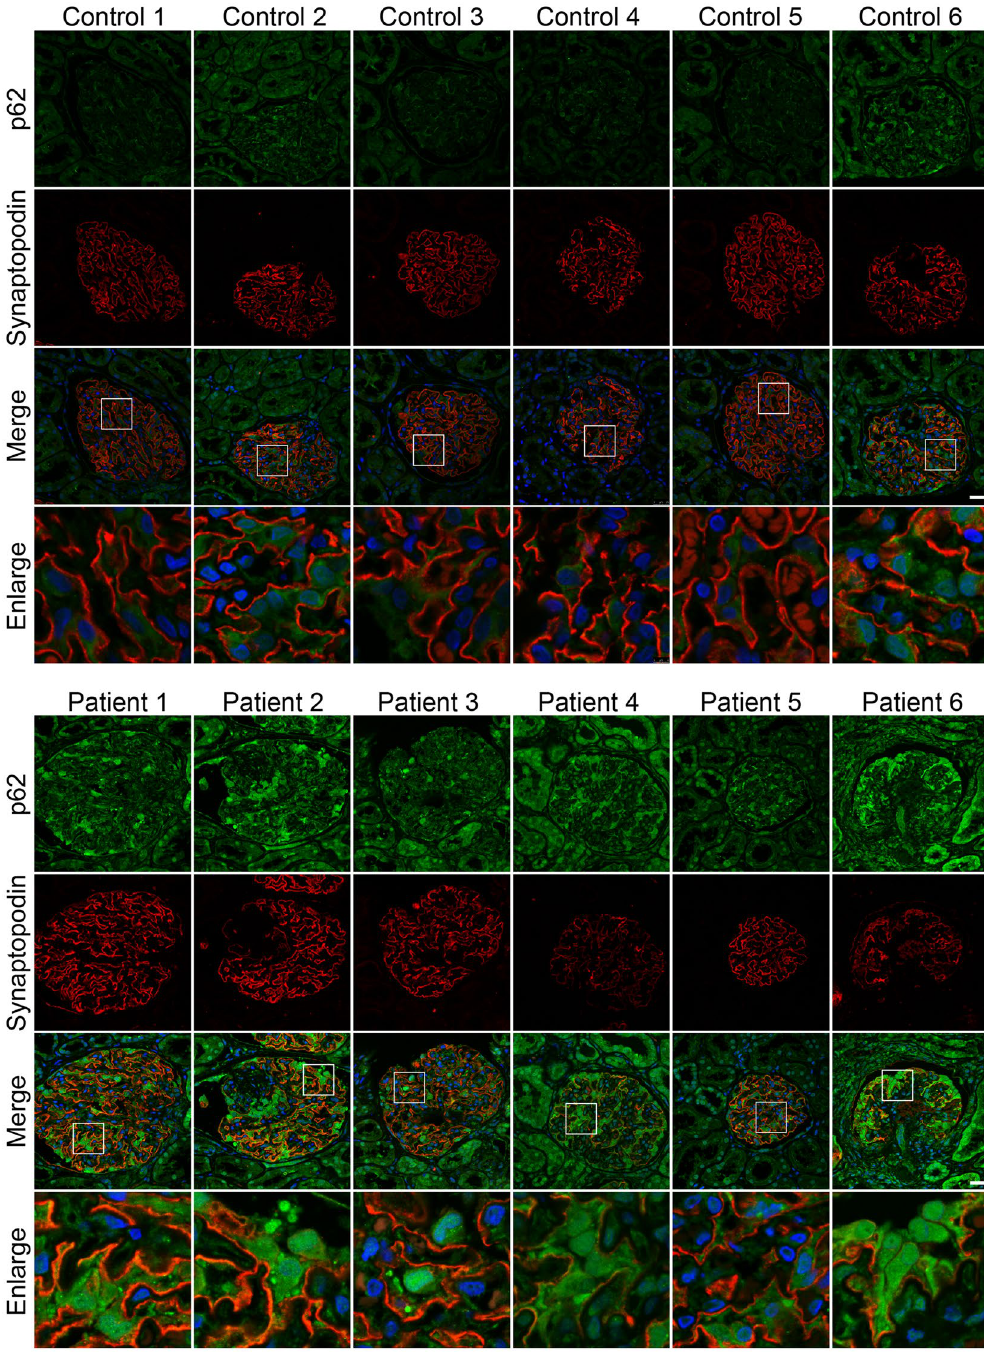
Figure 2. Autophagy impairment in podocytes of patients with idiopathic membranous nephropathy (IMN). Immunofluorescent analysis showing large accumulations of p62 protein (green) in podocytes of patients with IMN. The podocytes in glomeruli were identified by immunofluorescent double-labeling with synaptopodin (red), a podocyte foot process-specific protein. The nuclei were stained with DAPI (blue). Images were obtained using a confocal microscope. Scale bar, 25 μ